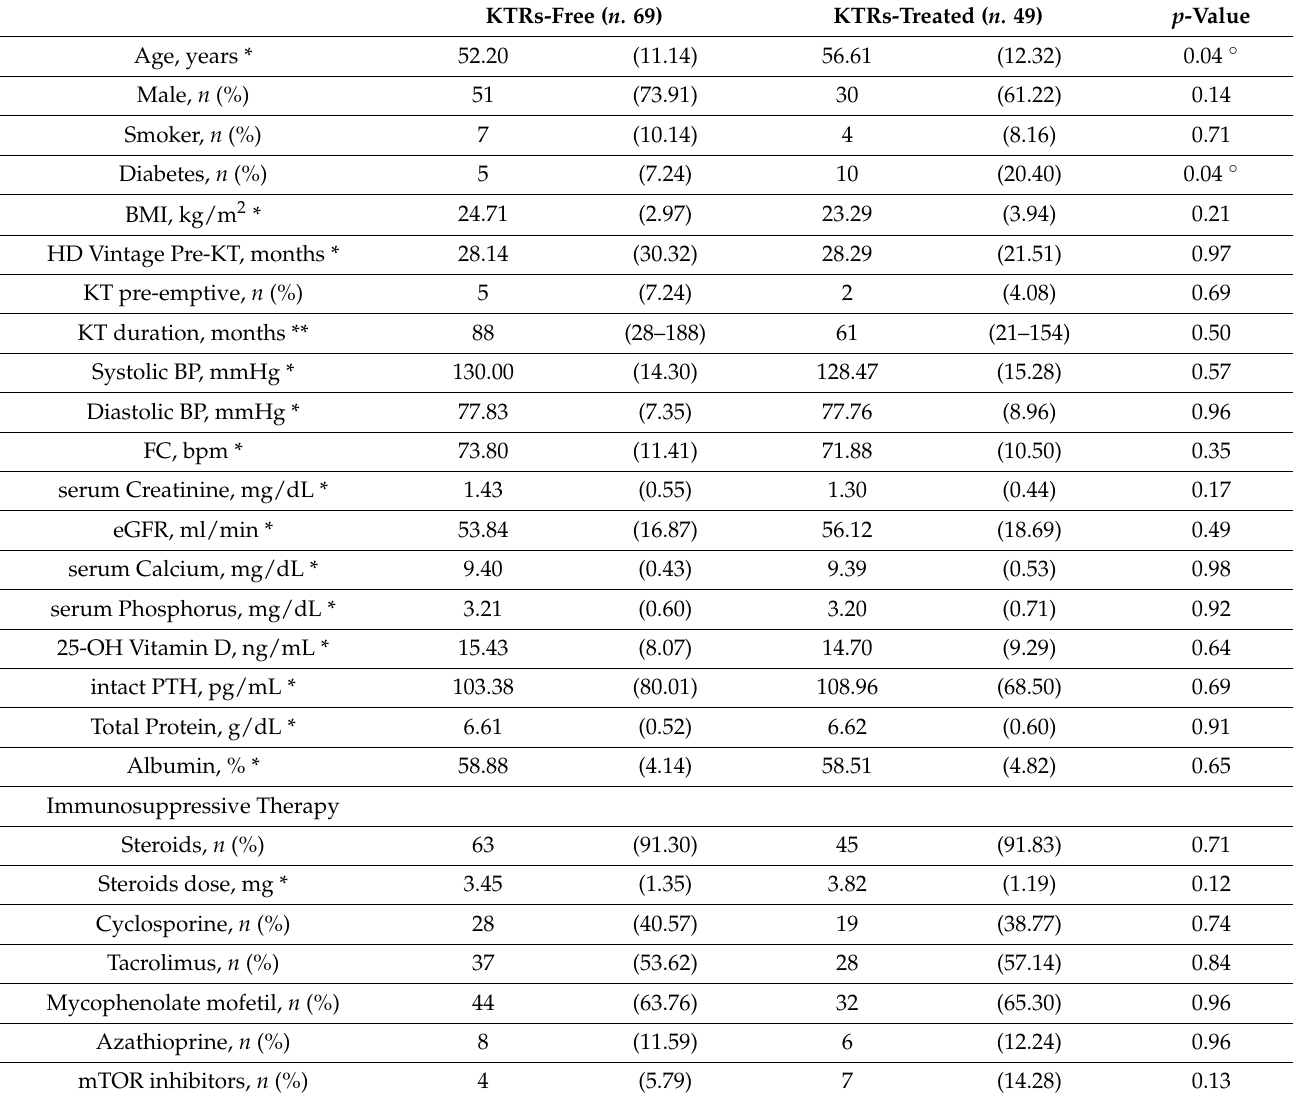
Table 1. Demographic and biochemical data of KTRs-treated and KTRs-free at baseline. KTRs-Free ( n. 69) KTRs-Treated ( n.